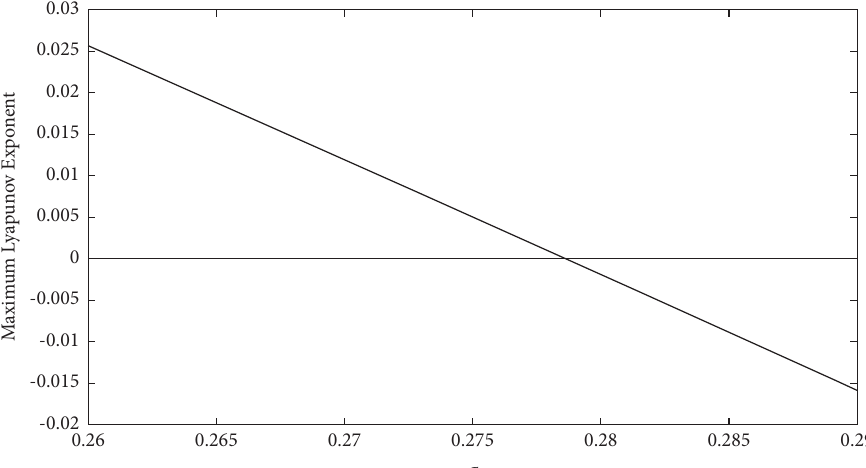
Figure 6: Te image of the maximum Lyapunov exponent about σ , where R � 2 ,k � 1 , c � 0 . 8 , σ ∗ � 0 . 278652 and the value of σ from 0.26 to